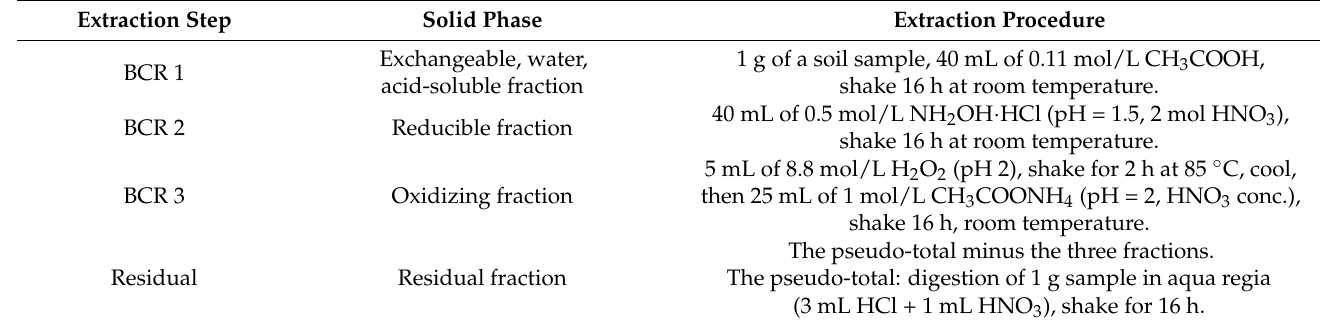
Table 2. Modified BCR three-step sequential extraction procedure